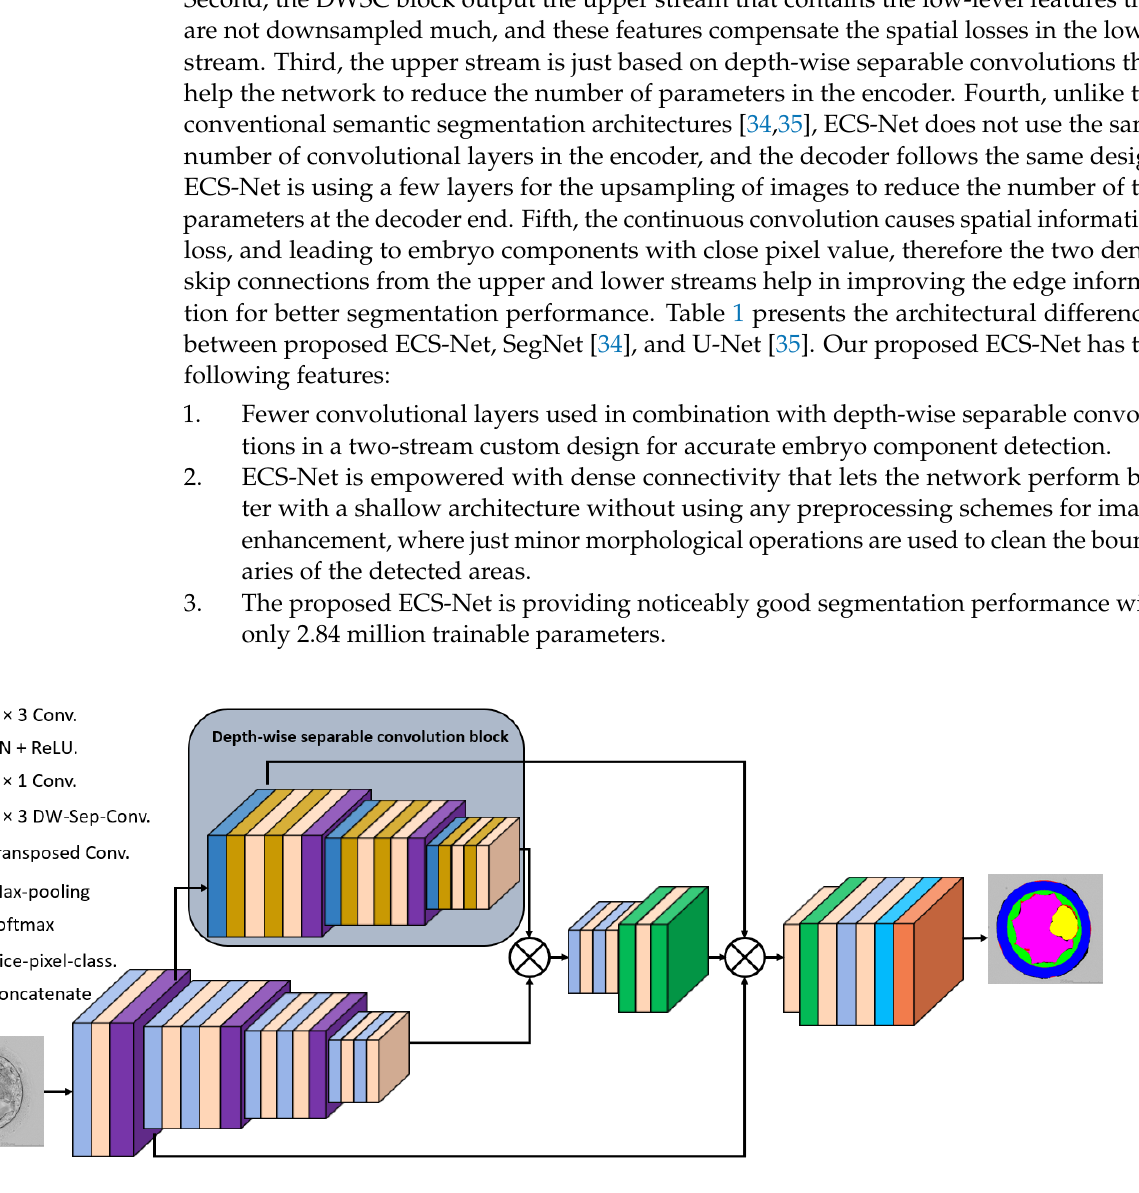
Figure 3. Architecture of the proposed